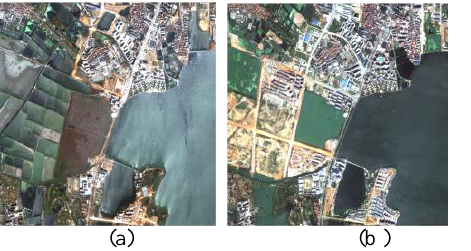
Figure 2 . Change detection imagery acquired in (a) 2002 and (b) 2005(758 × 623 pixels, with the spatial resolution of 2 m ).